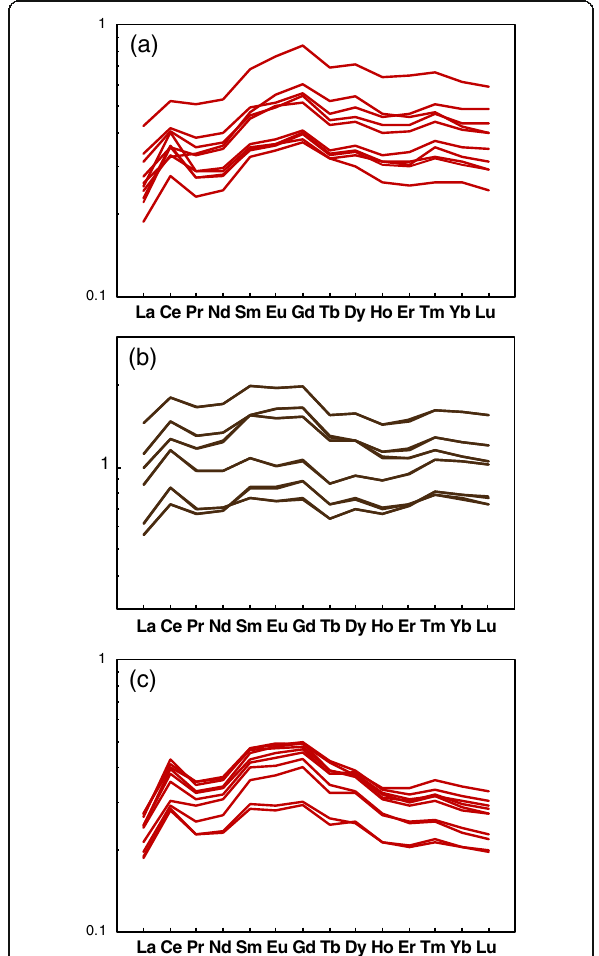
Fig. 10 UCC-normalized REE patterns of the chert and claystone samples. a Chert layers in the E2 interval, b claystone layers in the E1 interval, and c chert layers before the impact